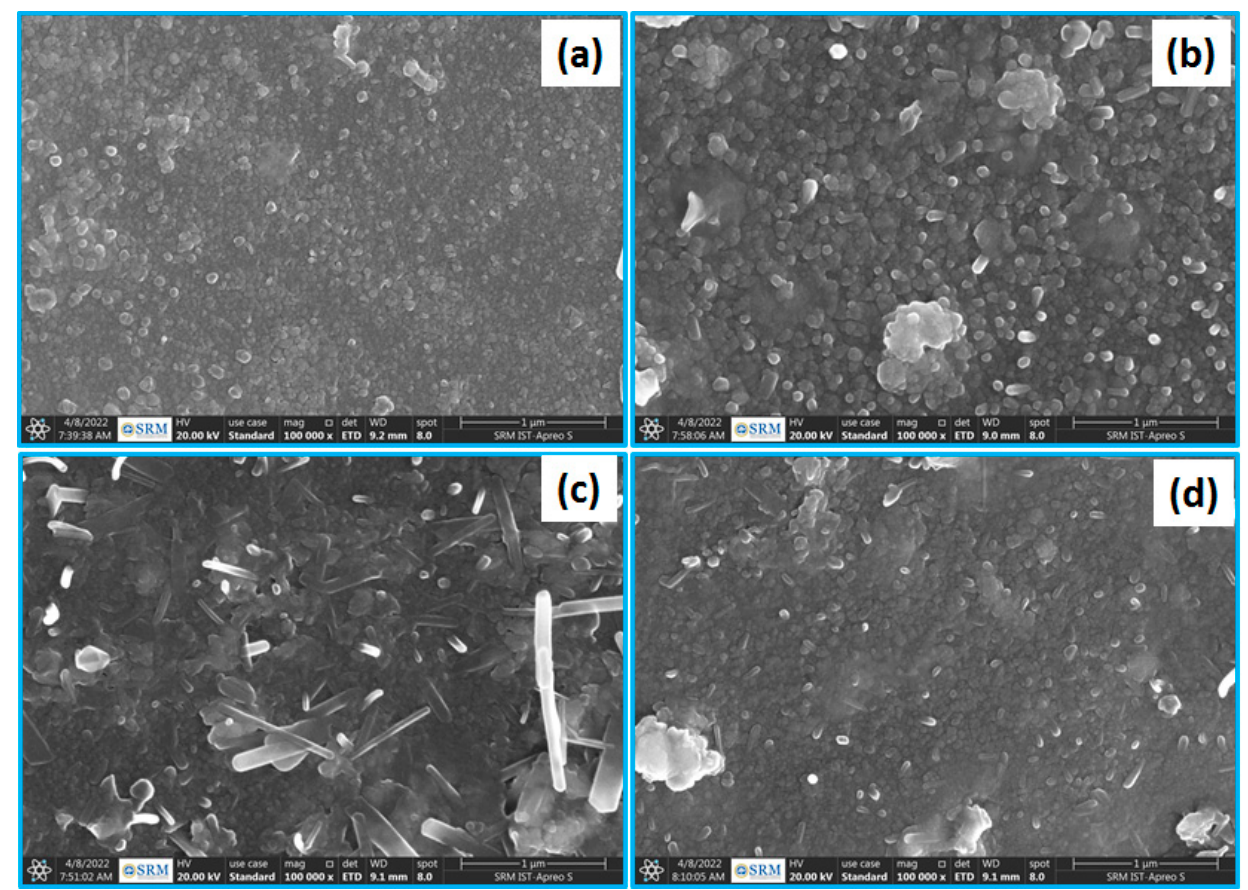
Figure 2. FESEM images of Eu-doped Bi 2 S 3 thin films with different Eu concentrations ( a ) 0%, ( b ) 1%, ( c ) 3%, and ( d ) 5%.